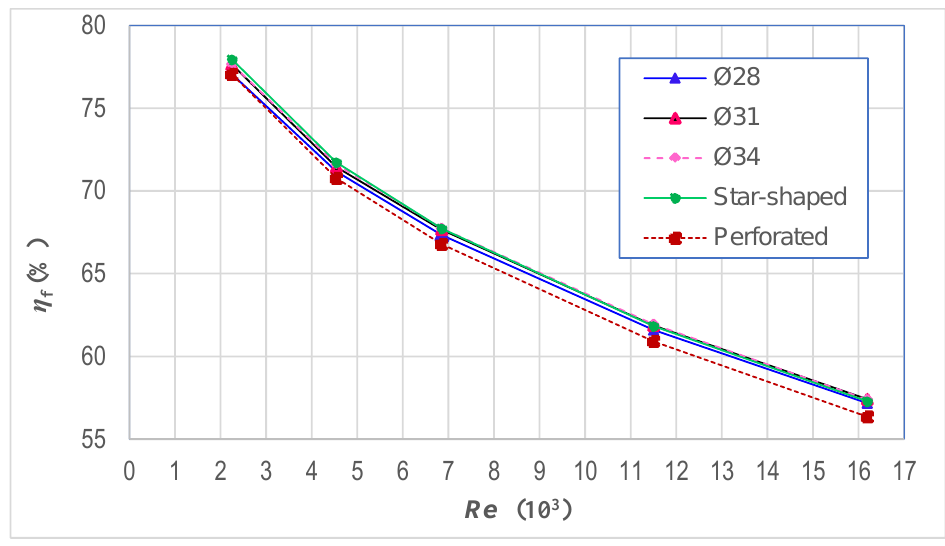
Figure 12. Fin efficiency.